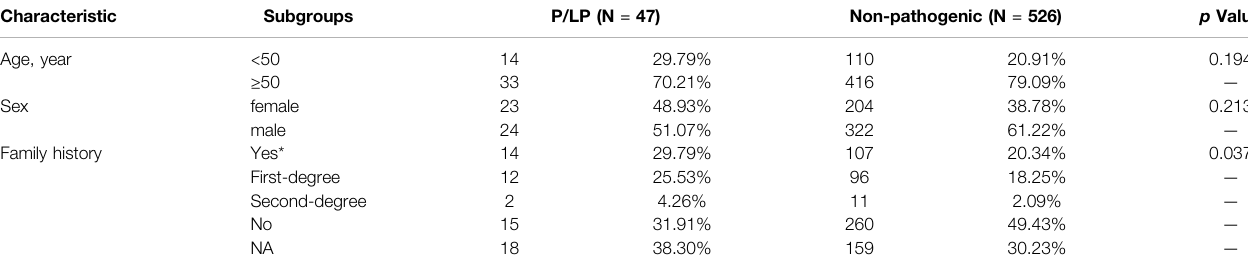
TABLE 2 | The summary of clinicopathological and history information for bowel cancer patients with or without distinct germline mutation pathogenicity.